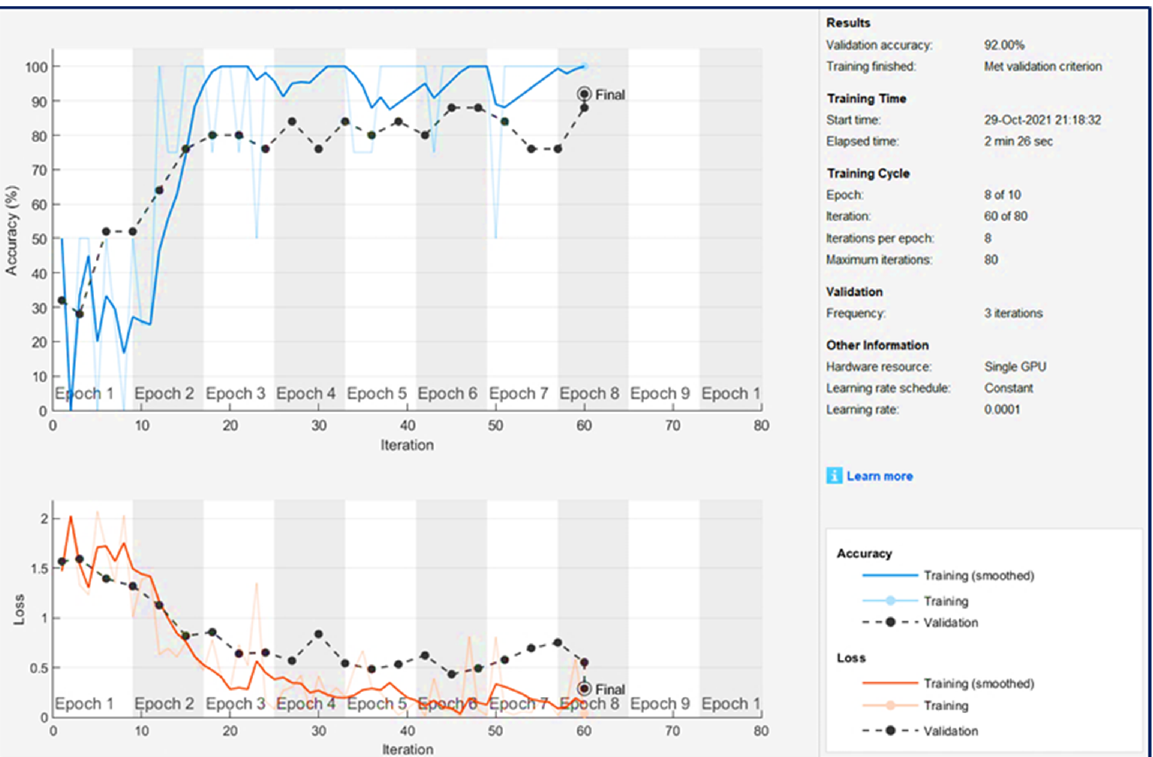
Figure 13. DenseNet training and verification network monitoring results.